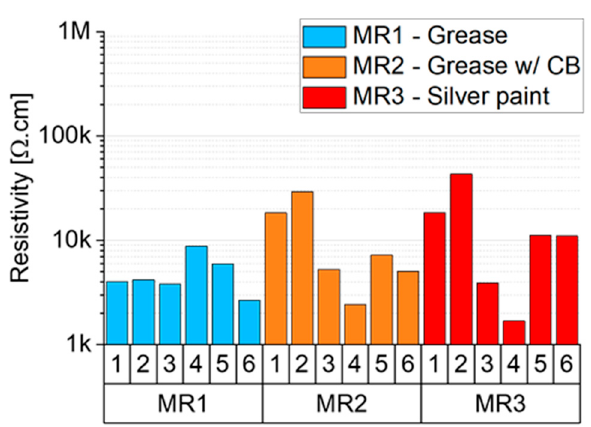
Figure 9. With electric field: Impact of mold release agent on resistivity of SWCNT/epoxy 0.01 wt.% individual samples cured at 100 °C.